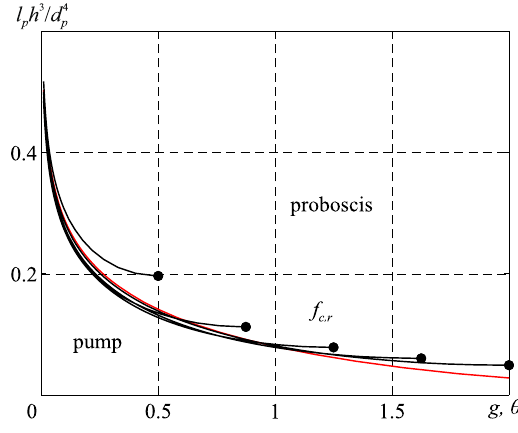
Figure 8. Classification of the pump–proboscis pair with respect to energy dissipation mechanisms. The sequence of curves is the same as that in Fig. 7. The red curve indicates a circular pump, and the black curves indicate rectangular pumps. All parameters used to calculate these black curves are identical to those in the caption of Fig.